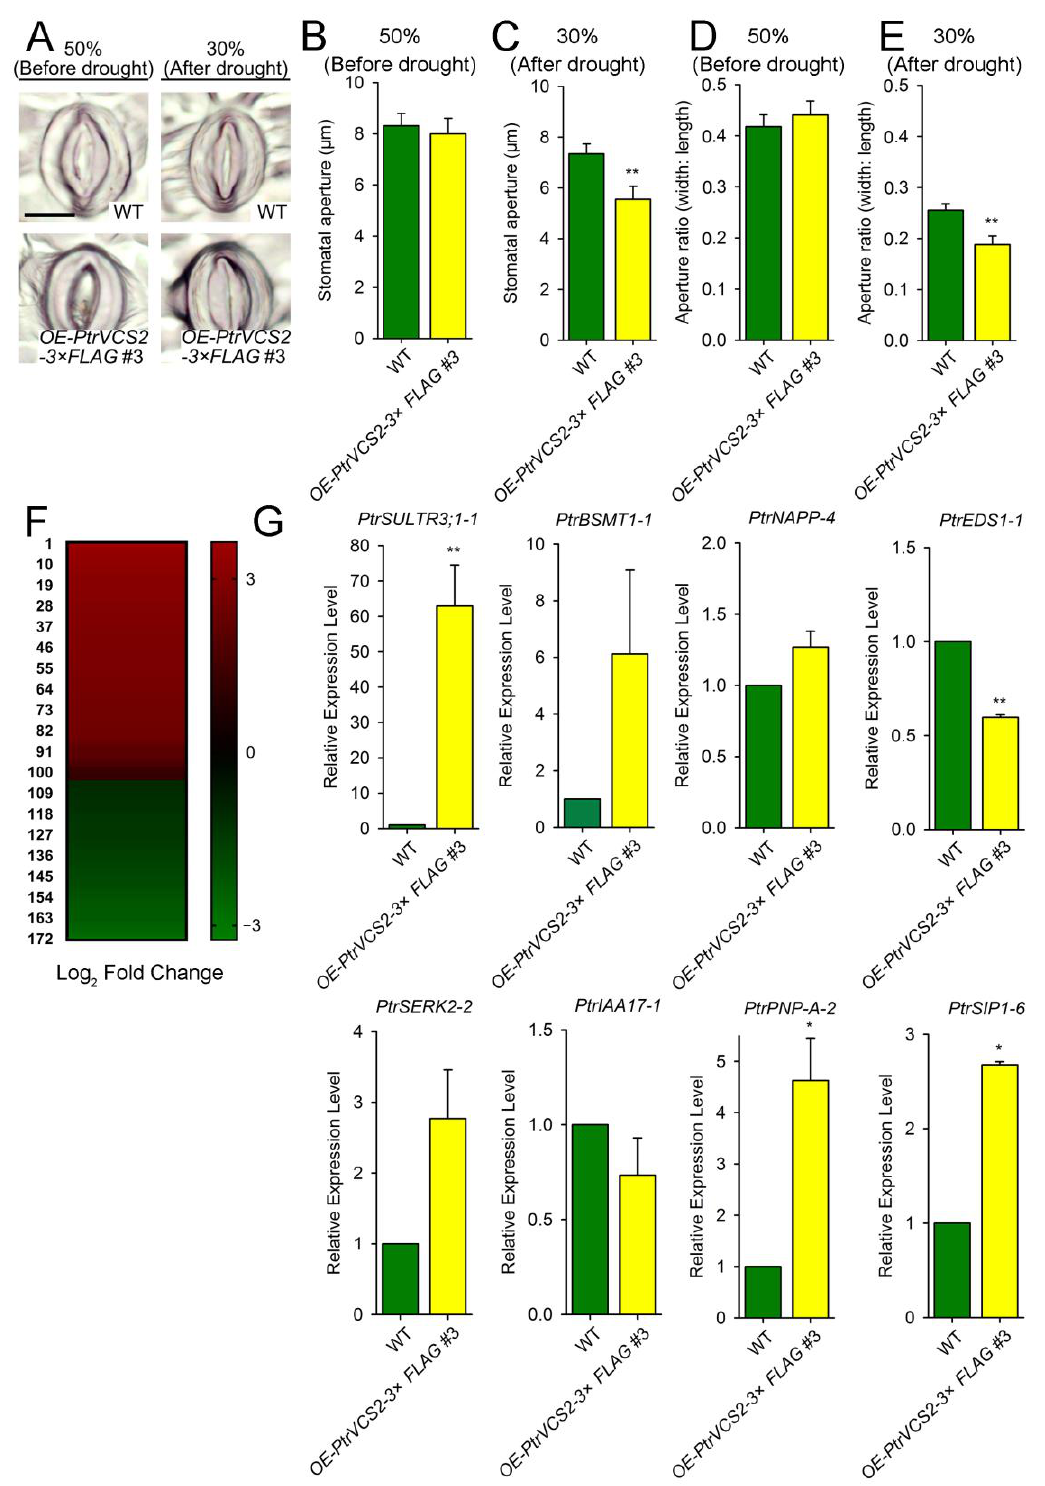
Figure 3. The stomata aperture of the wild-type and OE-PtrVCS2 plants in response to drought stress. ( A ) Photographs of stomata on the leaves of the wild-type (WT) and OE-PtrVCS2 plants before or after drought stress treatments. Bars = 20 μm. ( B ) The stomatal aperture under the condition with 50% VWC (before drought stress treatments). ( C ) The stomatal aperture under the condition with 30% VWC (after drought stress treatments). ( D ) The aperture ratio under the condition with 50% VWC (before drought stress treatments). ( E ) The aperture ratio under the condition with 30% VWC (after drought stress treatments). ( F ) Identification of differentially expressed genes in the OE- PtrVCS2 transgenics under the drought condition. ( G ) The relative expression levels of the genes